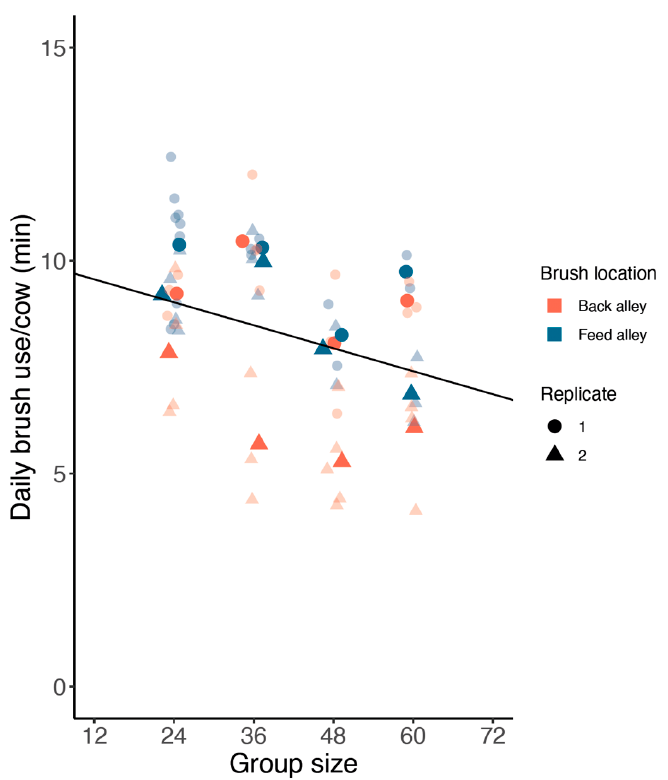
Figure 2. Solid colored points show the average daily brush use per cow across days based on a single mechanical brush placed in four different group size conditions positioned in the feed alley or in the back alley; data are reported separately for each of two replicates. Small transparent points show the average brush use values per cow for the days analyzed in each treatment condition. Points are spread out around respective group size on the x axis to avoid overlap. Fitted line indicates the linear relationship between group size and average daily brush use duration per cow.